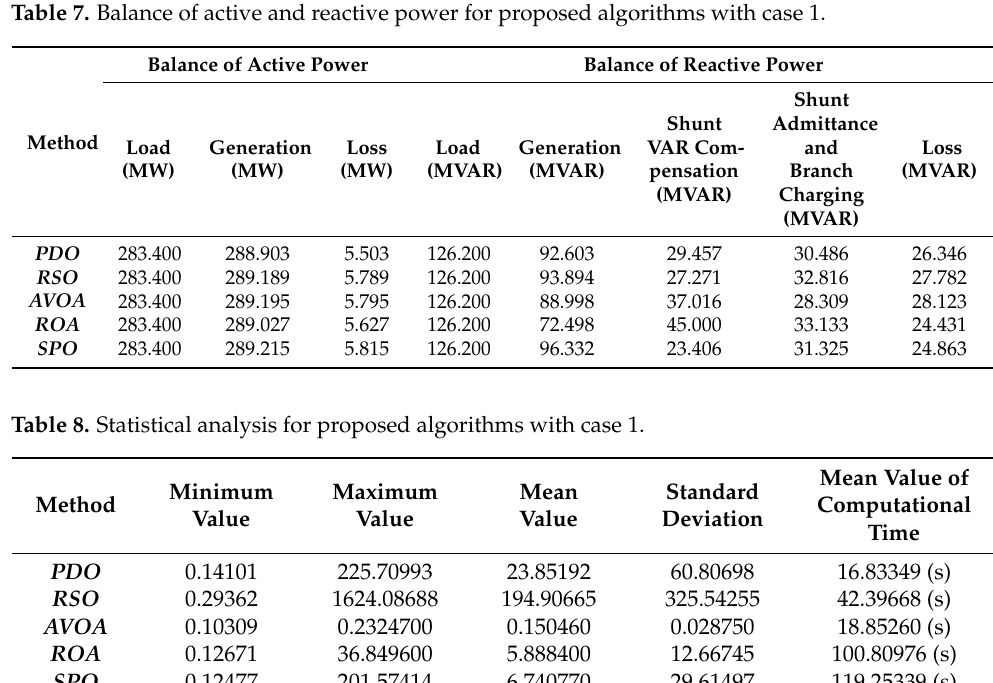
Figure 4. The AVOA convergence characteristics with the other compared methods for case 1.